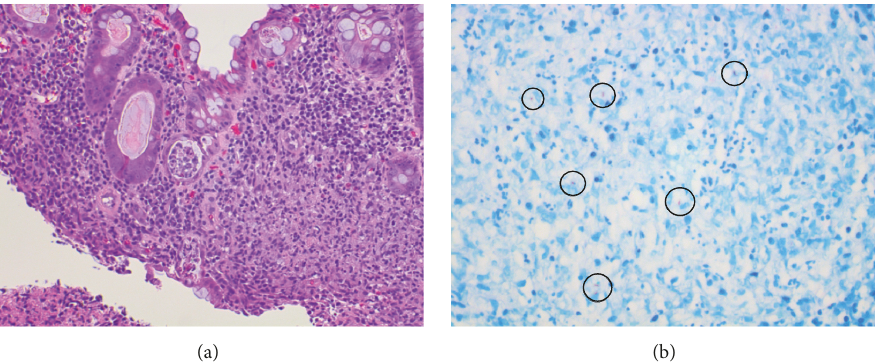
Figure5:(a)20xhematoxylinandeosin(H&E)staindemonstratingactivecolitiswithcryptabscessandanill-defineddefinedgranulomatous area. (b) 40x AFB stain of the splenic flexure with necrotizing granuloma and acid-fast bacilli